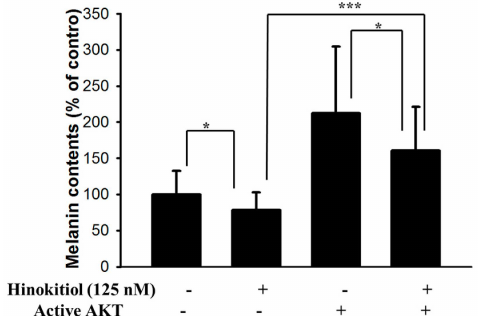
Figure 5. Hinokitiol reduces melanin content through AKT pathway. The B16F10 (10 5 ) cells were transfected with constitutively active AKT plasmid (5 µ g) for 16 h prior to treated with hinokitiol (125 nM) for 48 h. The melanin expression were measured. * p < 0.05; *** p < 0.001 (mean ˘ SD, n = 6). Each experiment was repeated three times with similar